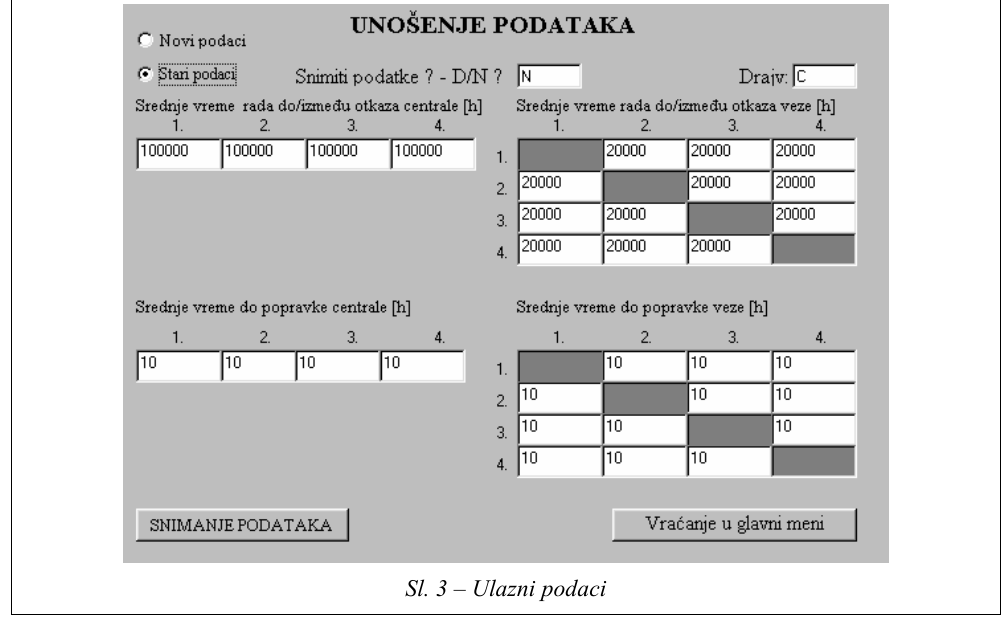
Sl. 3 (cid:150) Ulazni podaci